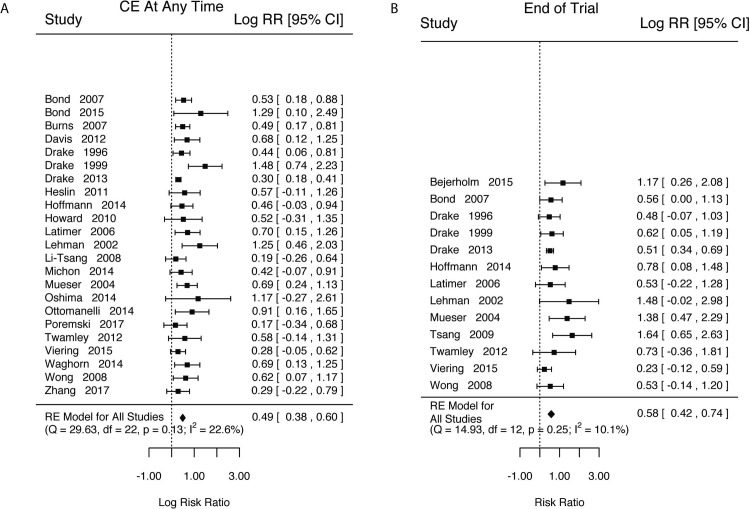
Competitive employment outcomes.A) For having held a competitive employment job for any portion of the experimental period B) For having held a competitive employment job at end of the experiment.